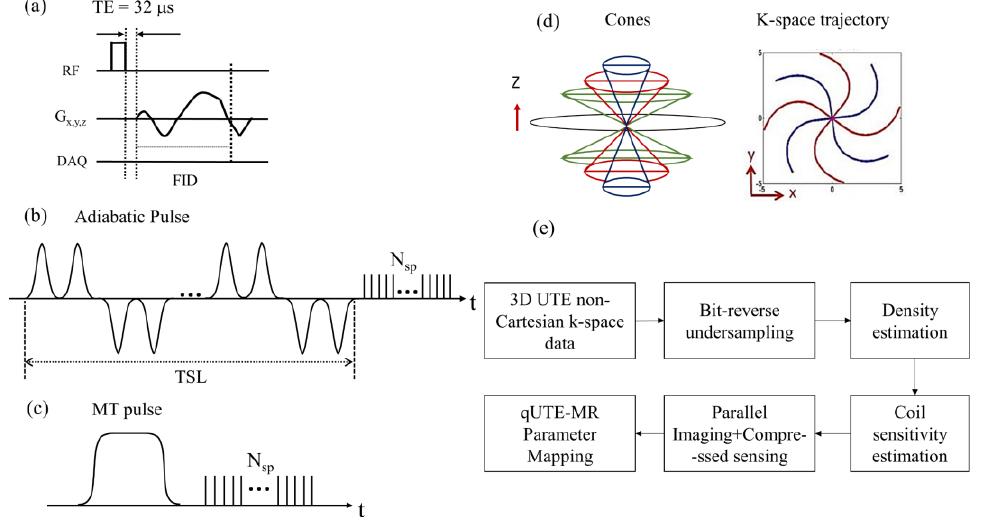
Figure 1. ( a ) UTE-Cones sequence with a short rectangular pulse, ( b ) adiabatic T 1 ρ signal preparation